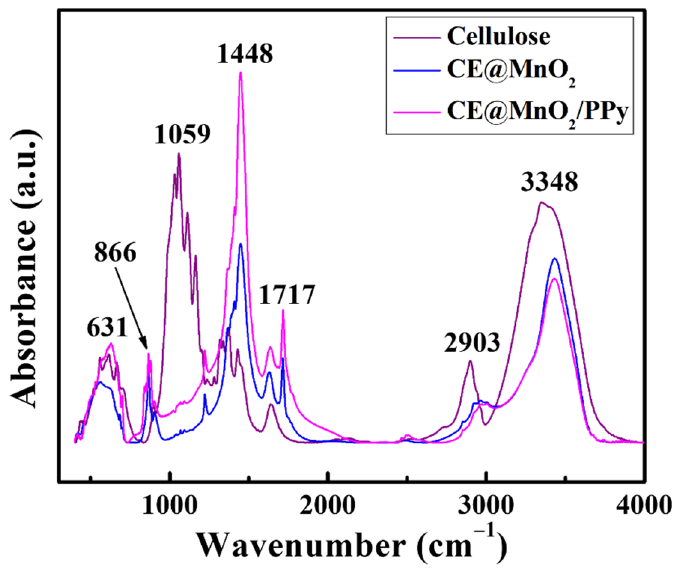
Figure 3. FTIR analysis of the Cellulose, MnO 2 @CE, and MnO 2